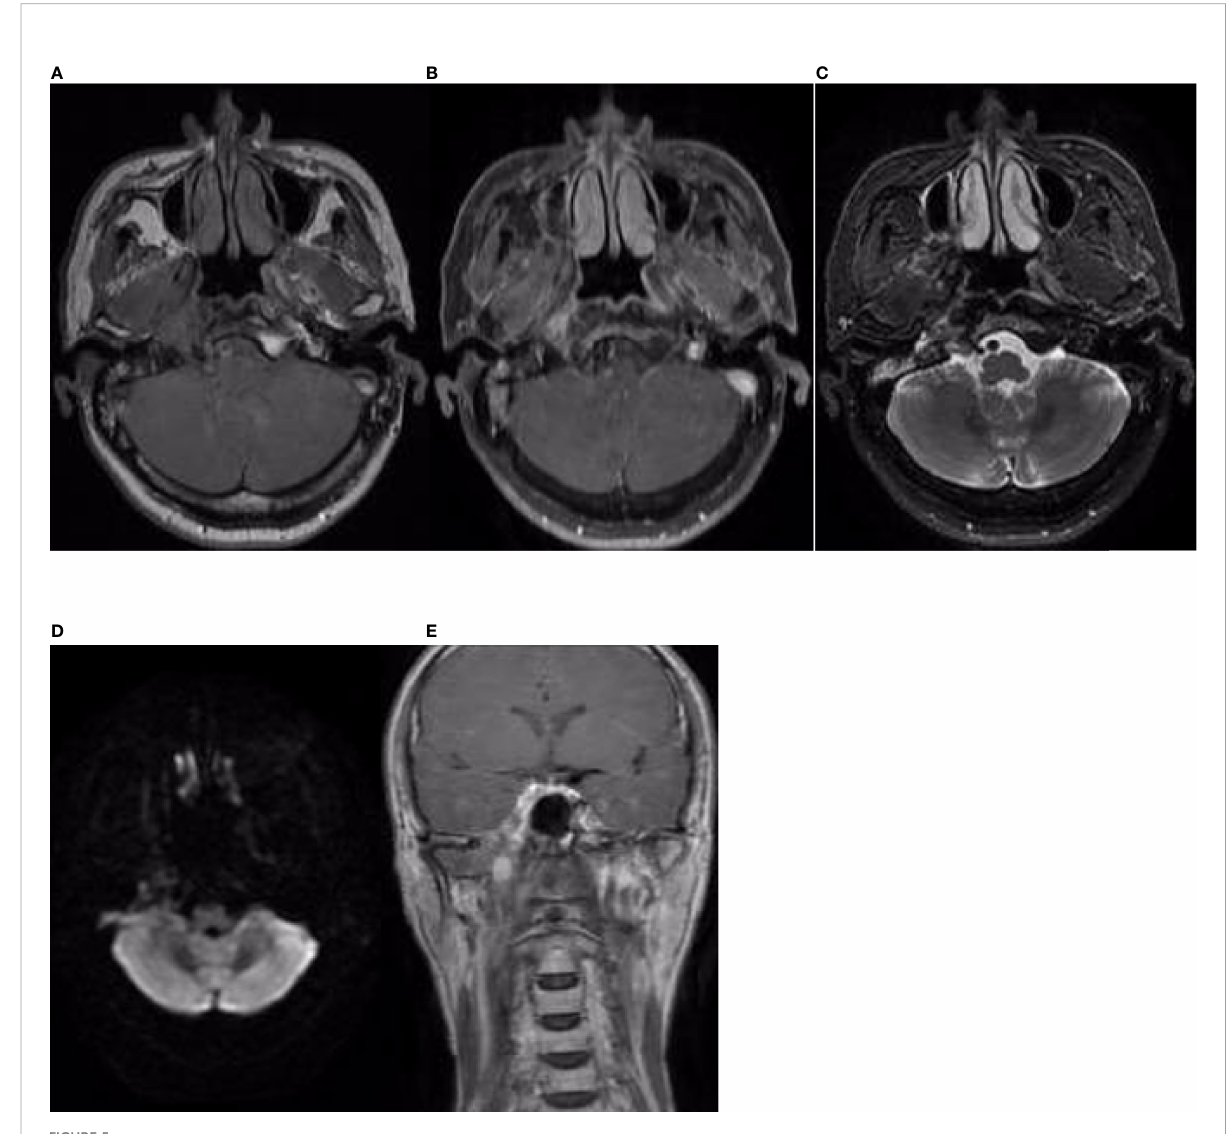
FIGURE 5 Nasopharynx and neck MRI fi ndings from 27 April 2021. (A – D) The axial planes of T1-weighted, enhanced T1-weighted, T2-weighted, and DWI and (E) the coronal plane of enhanced T1-weighted MRI, showing that the residual area of inhomogeneous enhancement had